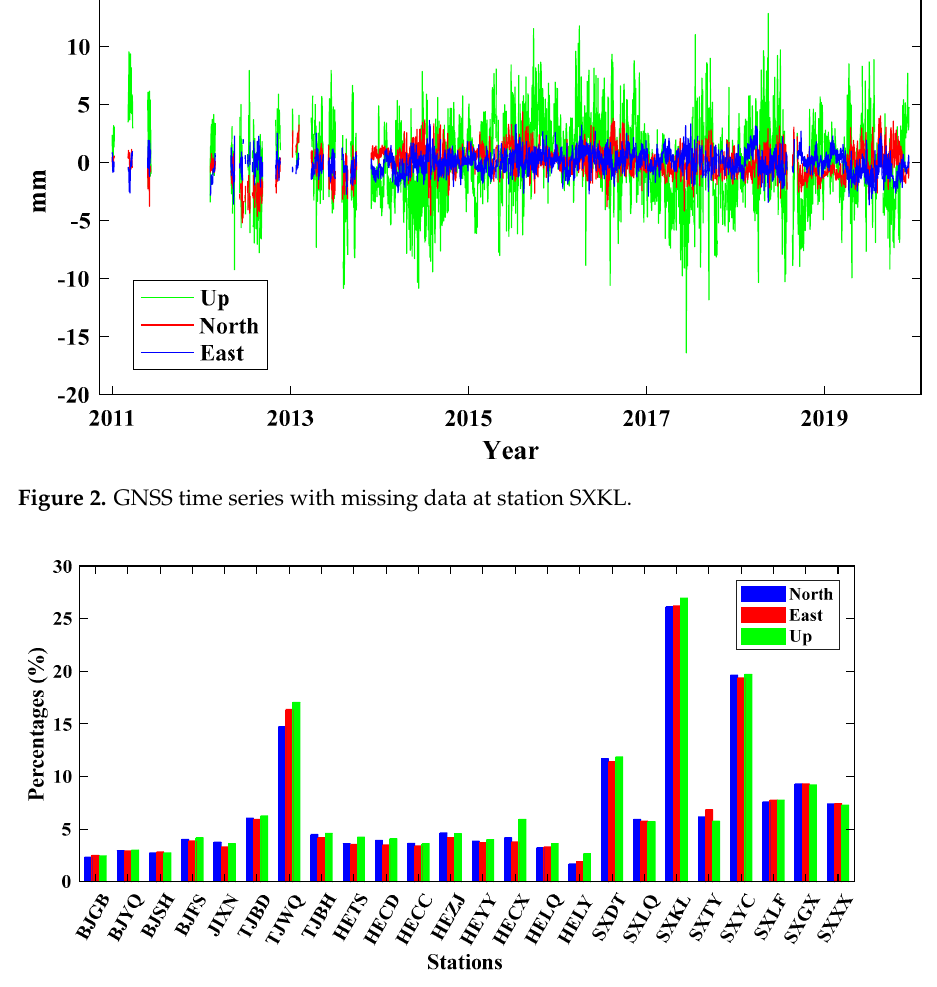
Figure 3. Missing percentages of 24 stations in North China from 2011 to 2019.